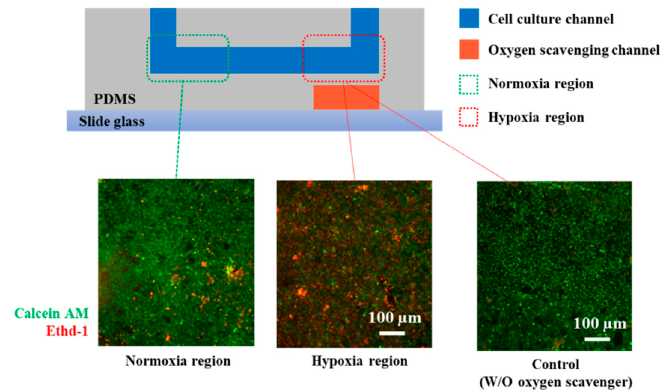
Figure 6. Live/dead assay of H9c2 heart myoblasts under normoxia and hypoxia conditions. H9c2 heart myoblasts were cultured on the normoxia and hypoxia regions in the microchannel. After 6 h of hypoxic condition, cells were stained for live/dead assay. Calcein AM (green fluorescence) presents live cells, and ethidium homodimer-1 (red fluorescence) presents dead cells.